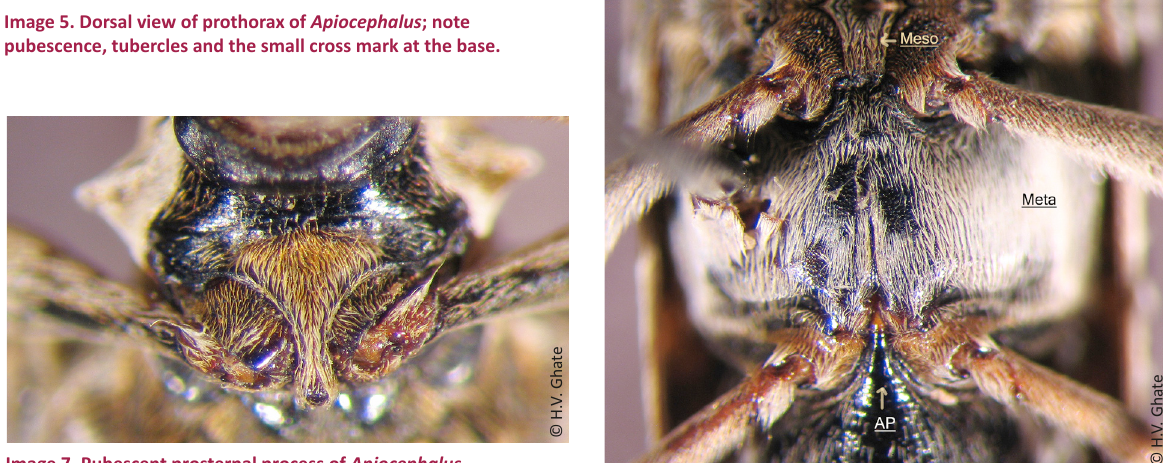
e a t G h V . H . © Image 8. Metasternum (Meta) of Apiocephalus showing part of mesosternum (Meso) and angular prolongation (AP) of abdominal ventrite.